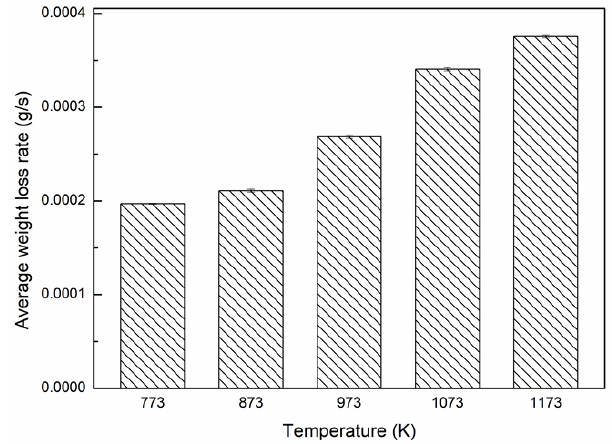
Figure 5. The effect of combustion temperature on the average weight loss rate.